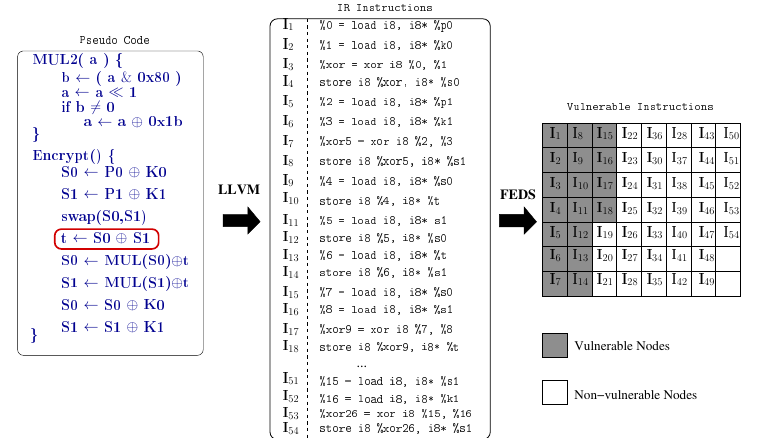
Figure 3: Vulnerable Instruction Identification. The Intermediate Representation obtained from the LLVM compiler for the pseudo code is used by FEDS to identify vulnerable